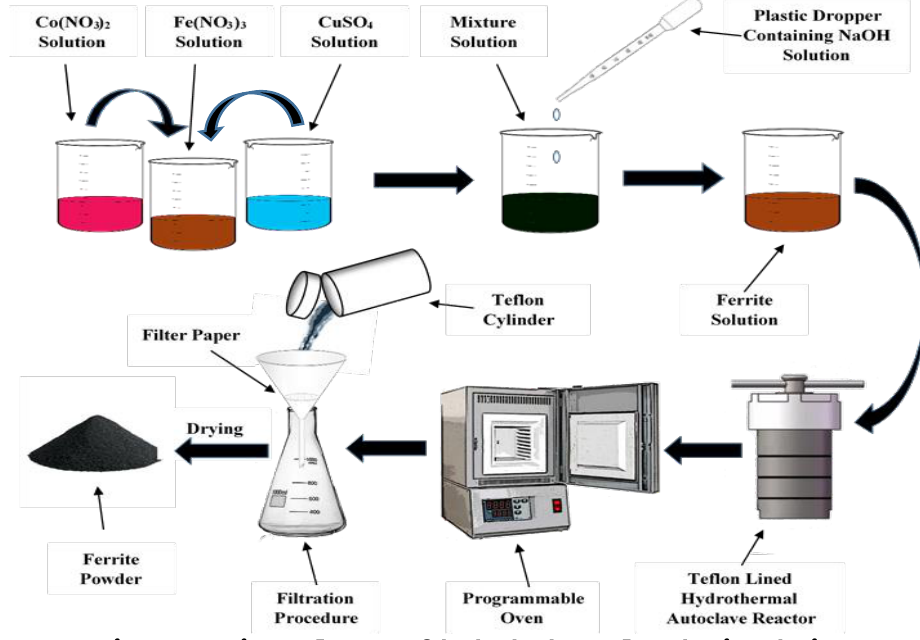
Fig.1: Experimental set up of the hydrothermal synthesis technique.